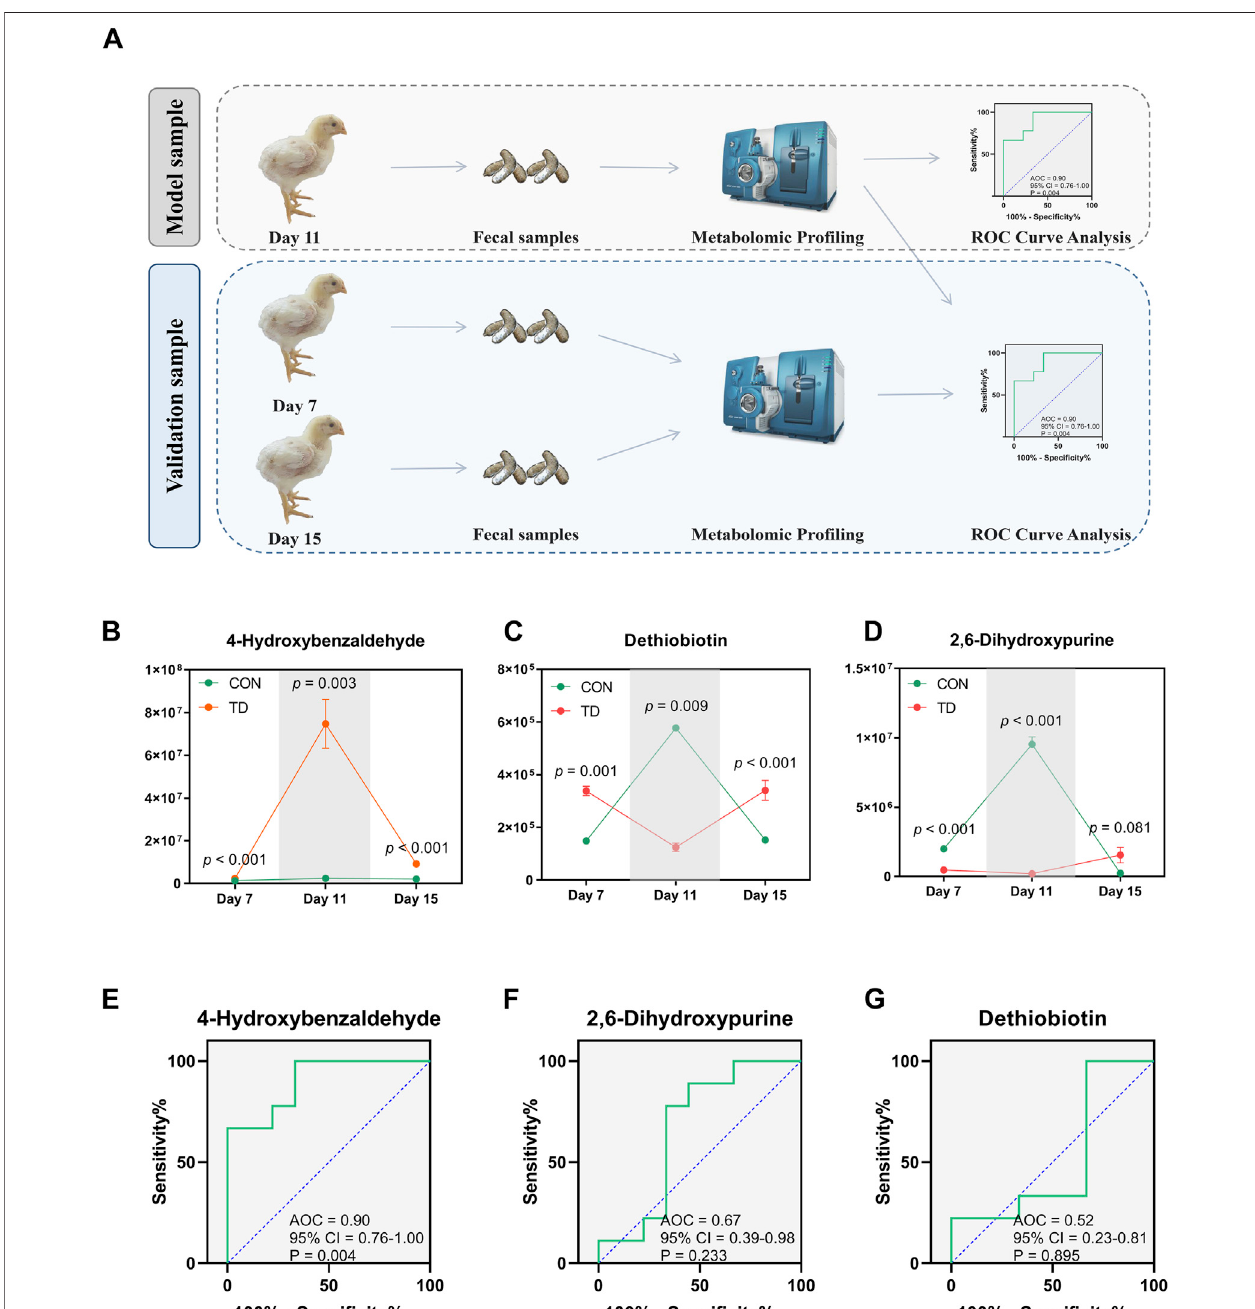
FIGURE 8 | Validation and evaluation of the predictive power of the three metabolites. (A) Design of veri fi cation experimental approach. (B – D) Statistical analysis wasperformedontherelativeabundancesofthethreedifferentialmetabolitesbetweengroupsbytheStudent ’ s t -test, a p -value < 0.05wasconsidered tobesigni fi cant (N=4). (E – G) CurvesofROCofdifferentialmetabolitebiomarkersfordiagnosisofTDduringtheentiretrial.AnAUCcloseto1.0indicateshighsensitivityandspeci fi city,a p -value < 0.05 was considered to be signi fi cant (N = 4).